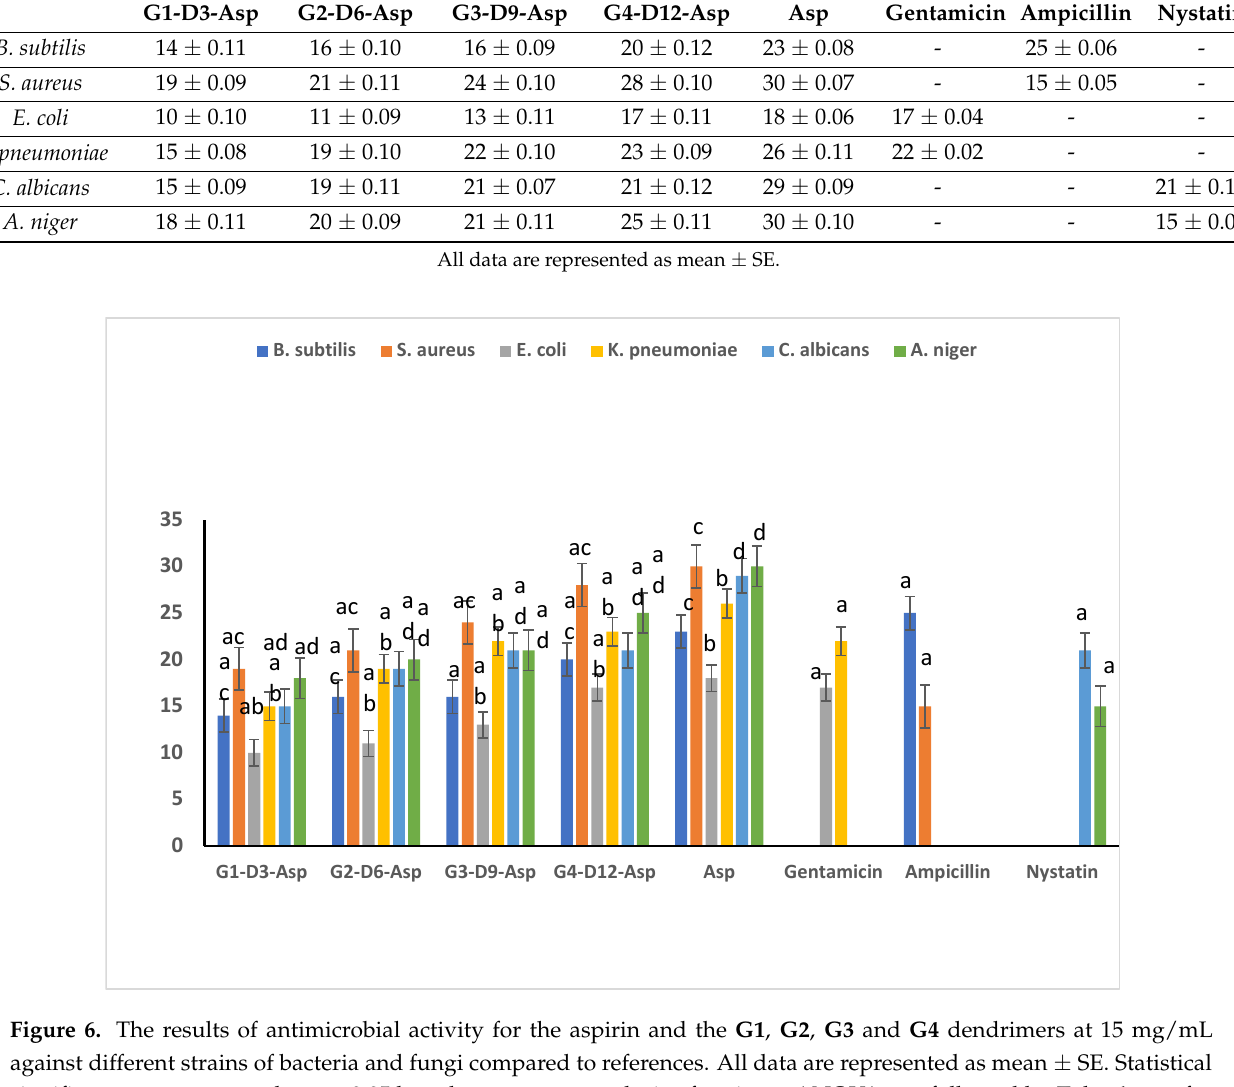
Table 1. The results of antimicrobial activity for the aspirin and G1-D3-Asp , G2-D6-Asp , G3-D9-Asp, and G4-D12-Asp at 15 mg/mL against different strains of bacteria and fungi compared to references.